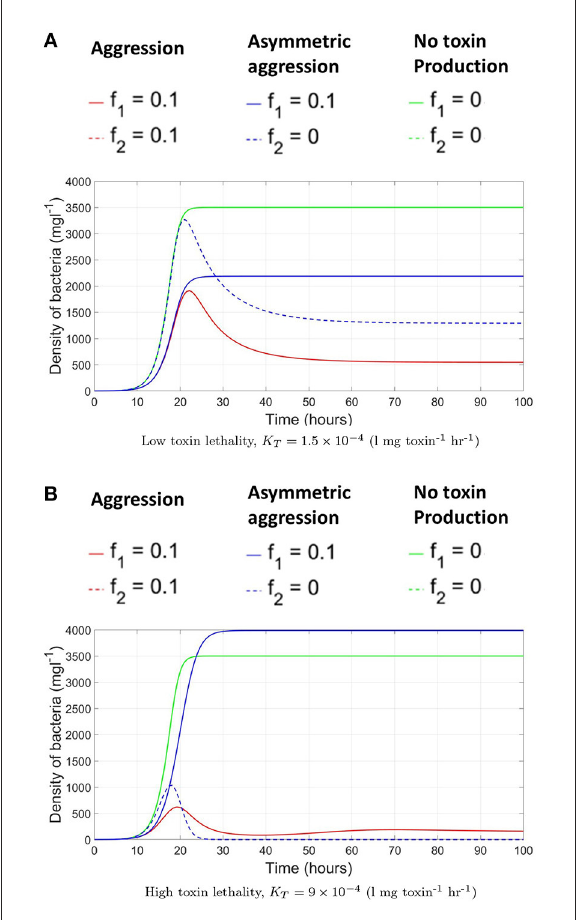
FIGURE2 The evolution of the biomass density of the two bacterial strains in time, under the scenarios of (i) symmetric aggression (red): both strains produce toxins, by setting the toxin investment fraction, f , for both of them to 0.1 (ii) asymmetric aggression (blue): one of the strains, P 1 , produce a toxin, f = 0.1, while the other fully invests in growth, f = 0 and (iii) No toxin production (green): the two strains do not produce toxins and both fully invest in growth, f = 0 for both strains. (A) At low toxin lethality. (B) At high toxin